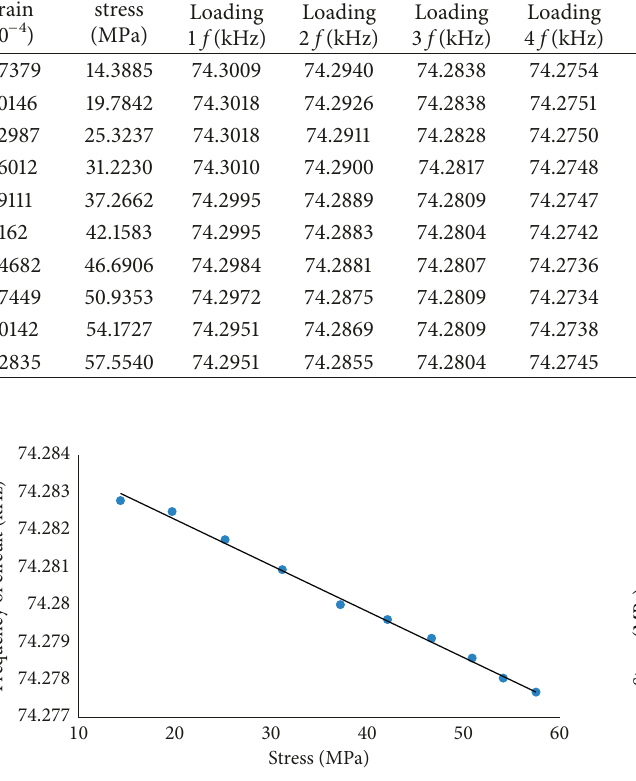
Figure 8: Relationship diagram between median frequency and median stress.